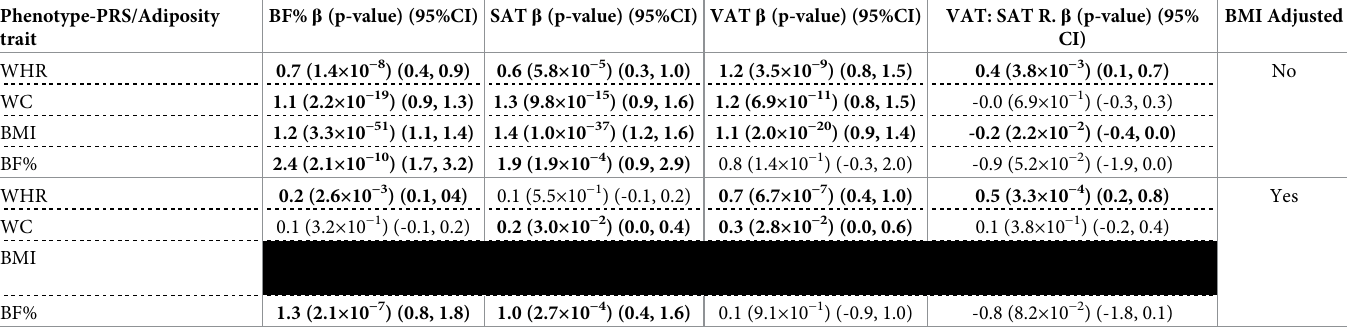
Table 2. Associations between phenotype-PRS (columns), and measures of adiposity (rows). Betas are reported for standardized inverse normalized values, followed by their respective p-values. Nominally statistically significant results (p < 5.00 × 10–2) are in bold font. Phenotype-PRS/Adiposity